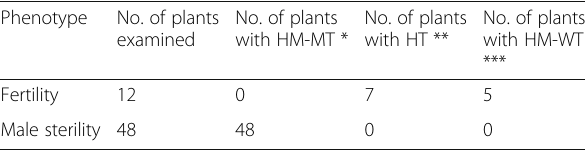
Table 1 Association analysis of the genotype and phenotype of oslap6 F2